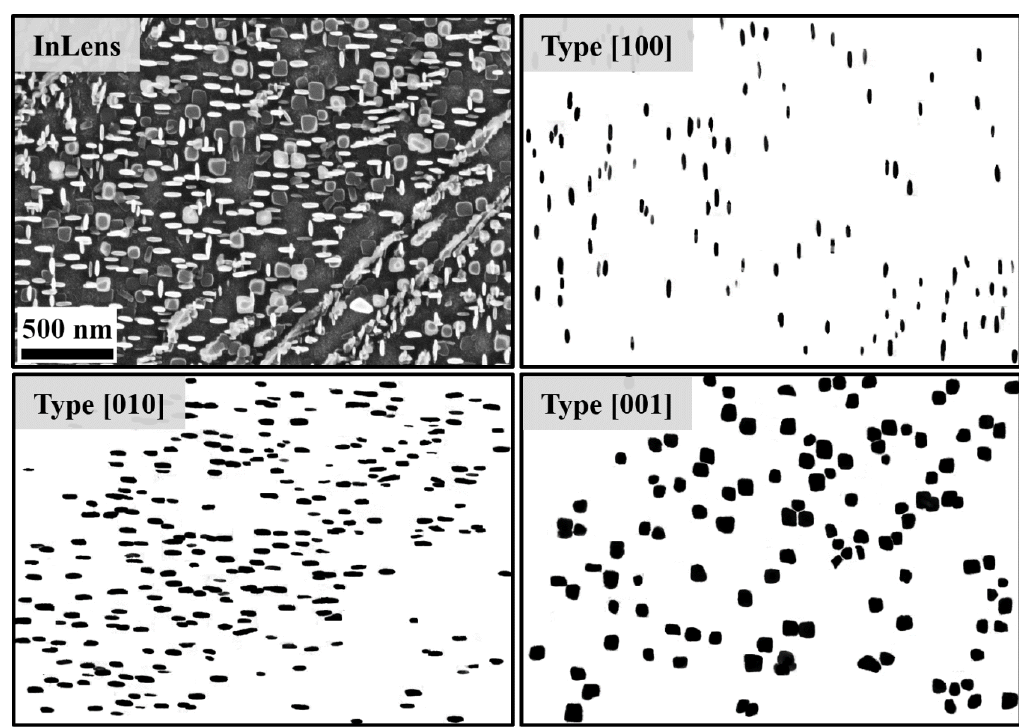
Figure 9. Binarization of the γ′′ particles from a sample after aging at 730 °C for 6 h with regard to three different crystallographic directions.